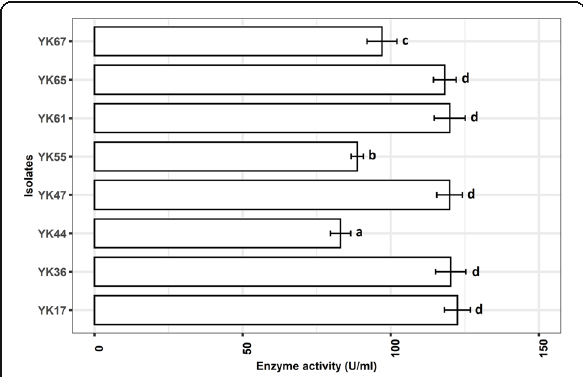
Fig. 2 Production of keratinase (U/ml) by the present study isolates. Bar with different superscript indicates significantly different at α level of